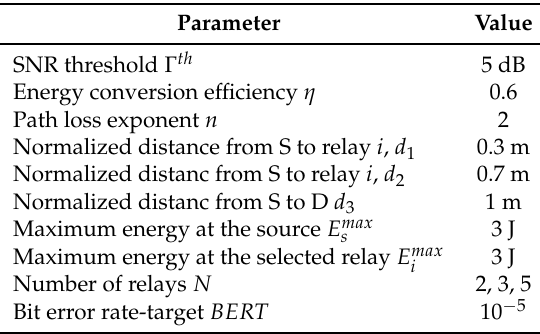
Table 1. Simulation Parameters.